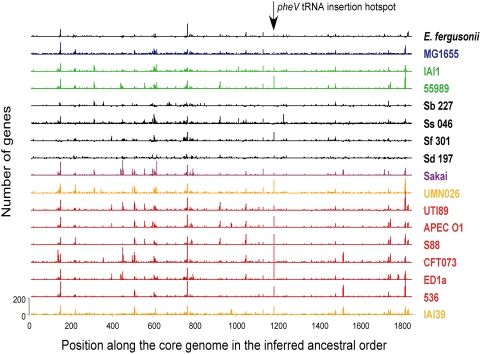
Global view of insertion/deletion hot spots.Number of genes (ranging from 0 to 200) in indels along the genomes of modern strains according to the ancestral gene order of the core genome. The numbers on the x-axis represent the order of genes in the core genome, which has the same order as E. coli K-12 MG1655.